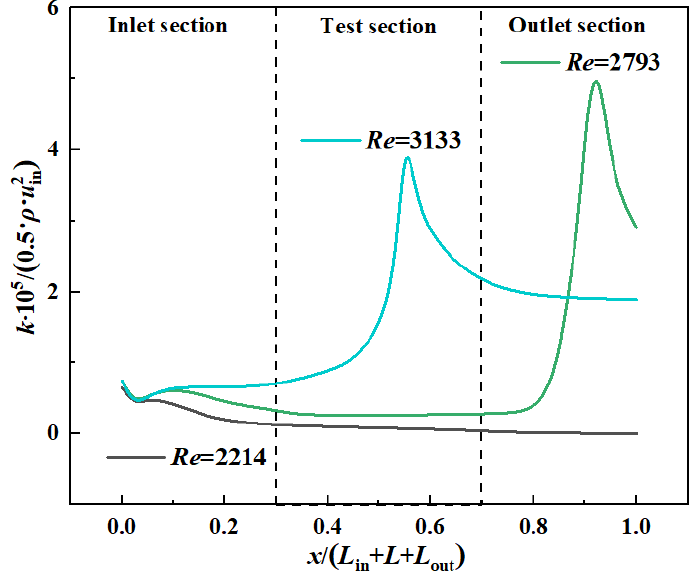
Figure 13. Dimensionless turbulent kinetic energy along the x coordinate.